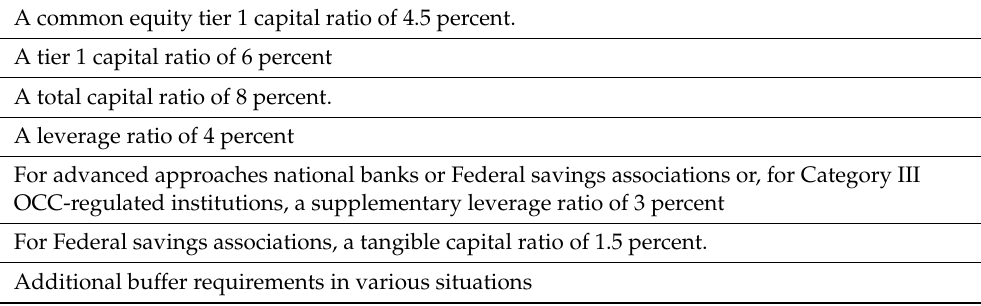
Table 2. Minimum Capital Requirements for National Bank or Federal Savings Association.